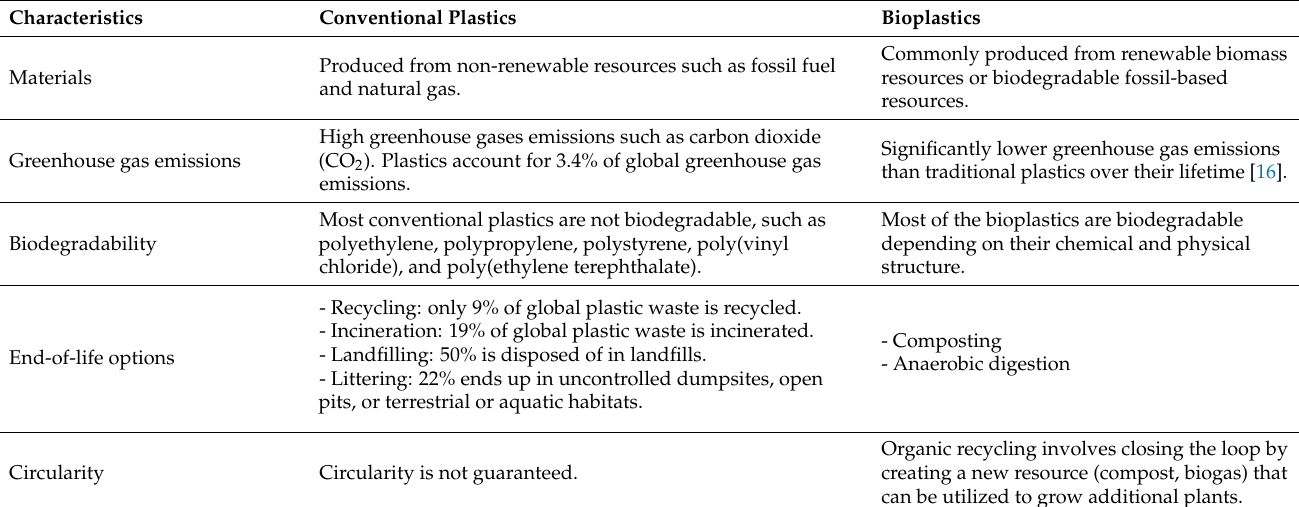
Table 1. Main differences between conventional plastics and